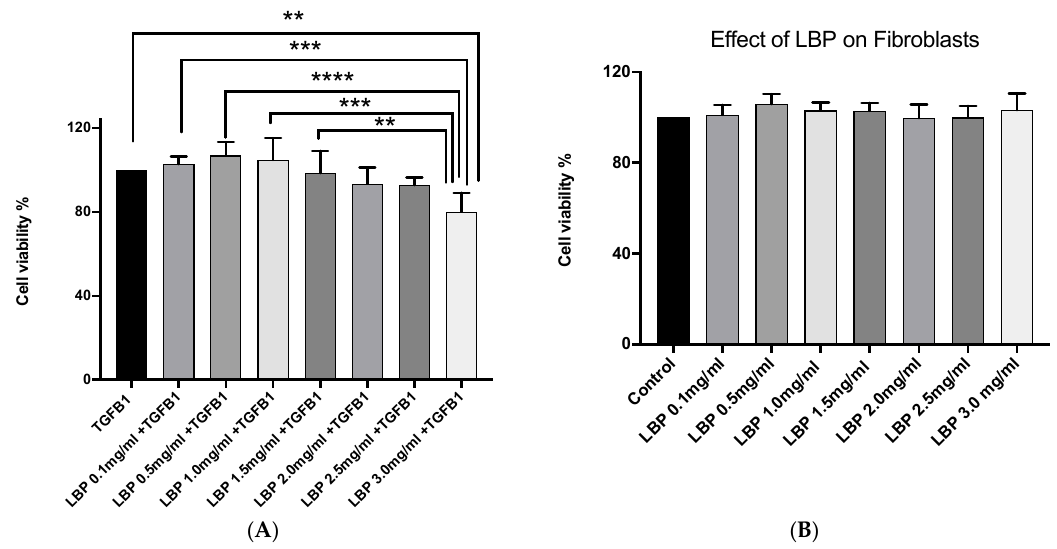
Figure 2. Graphs showing the effect of Lycium barbarum polysaccharides (LBP) on myofibroblasts ( A ) ( n = 5 for each group) vs. fibroblasts ( B ) ( n = 5 for each group) using one-way ANOVA, ** p < 0.01, *** p < 0.001, **** p <